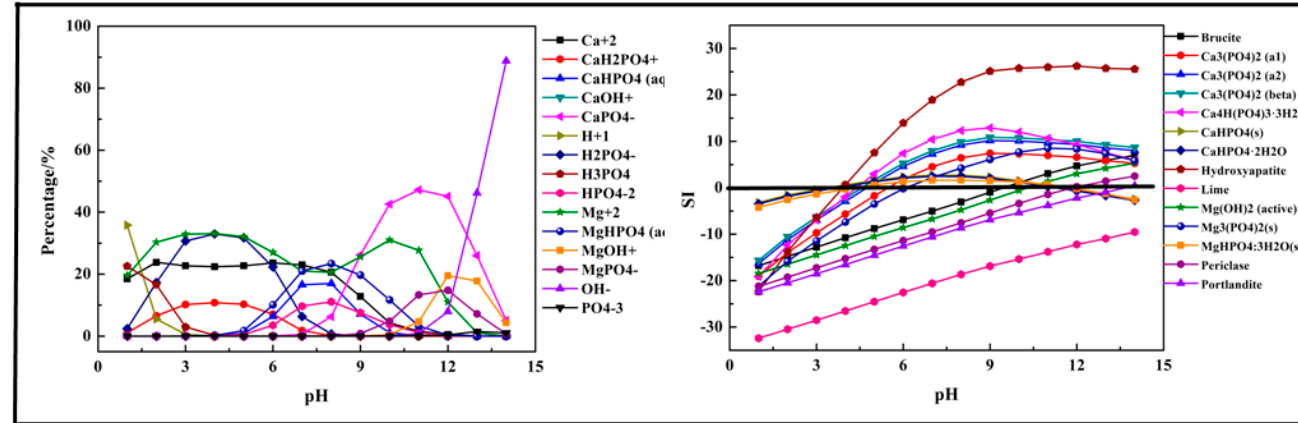
Figure 6. Percentage of species in the Ca-Mg-P-H 2 O system at 298 K at ranged pH ((P) = 0.01 mol/L, (Ca 2+ ) = 0.0075 mol/L, (Mg 2+ ) = 0.0075 mol/L).